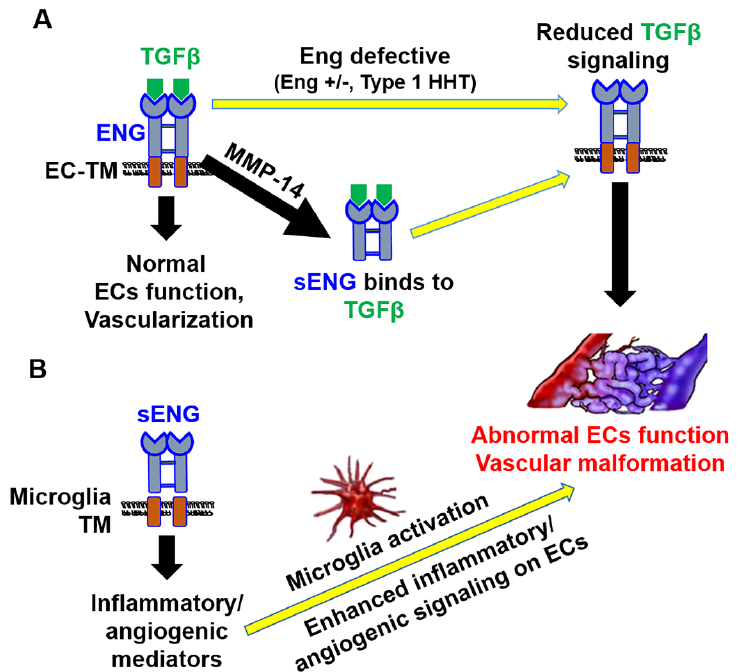
Figure 6. The role of soluble ENG in endothelial dysfunction and vascular malformation. (A) En- doglin (ENG) mediates the TGF β signaling pathway in endothelial cells (ECs). The mutation